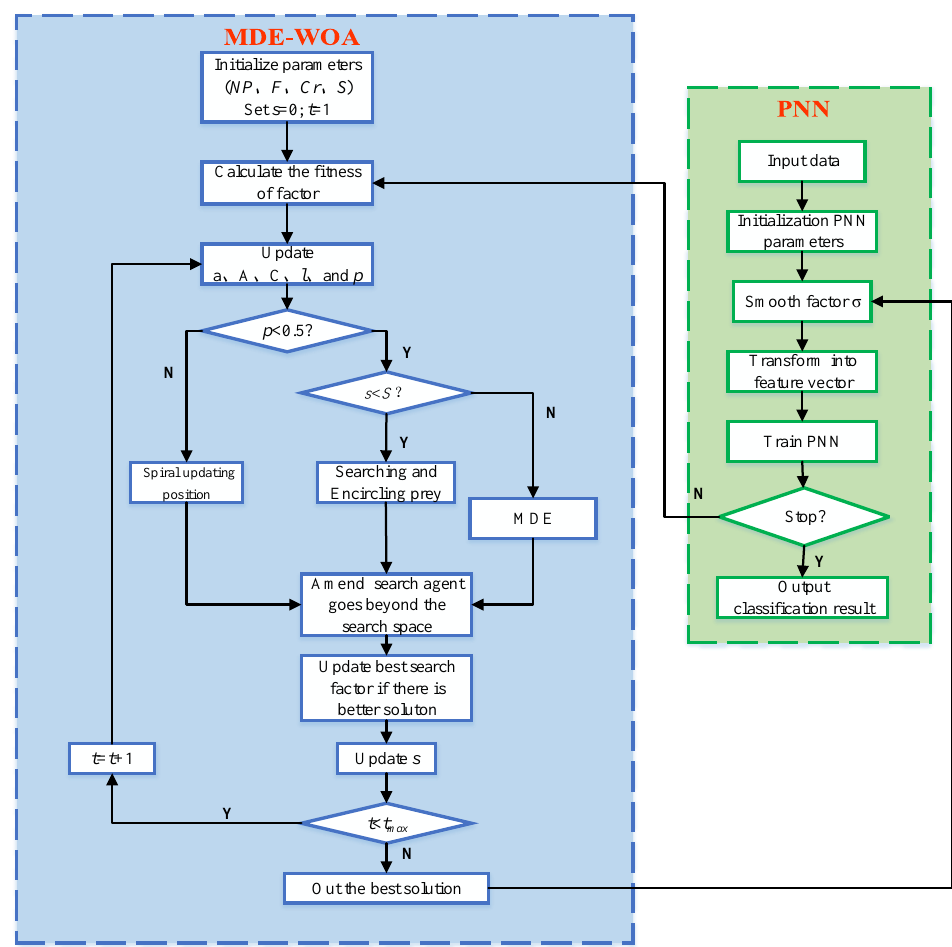
Figure 2. A modified differential evolution whale optimization algorithm (MDE-WOA) flow-chart. Step 1: Randomly generate initialization sample X